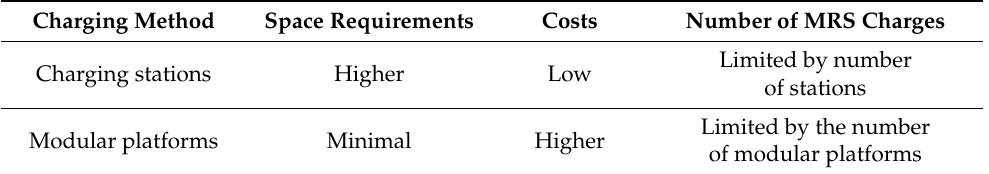
Table 6. Impact of MRS charging